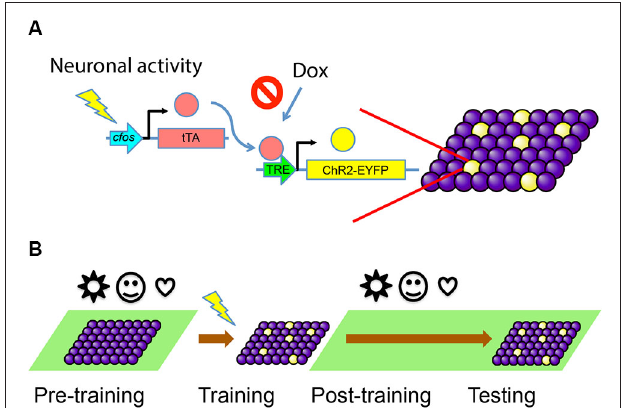
FIGURE 1 | Activity-dependent labeling of neurons. (A) Training-induced neuronal activity drives the expression of tTA, which in turn activates downstream gene expression through TRE promoter and labels active cells with ChR2-EYFP (yellow). This process can be blocked by the presence of Dox. (B) The animals are kept on Dox (green background) before the training, so any irrelevant stimuli (represented by various symbols) during this period will not cause cells to express ChR2-EYFP. The animals are taken off Dox during training, so cells active during the memory formation will be labeled. Animals are put back on Dox diet post-training and during testing, so no further labeling